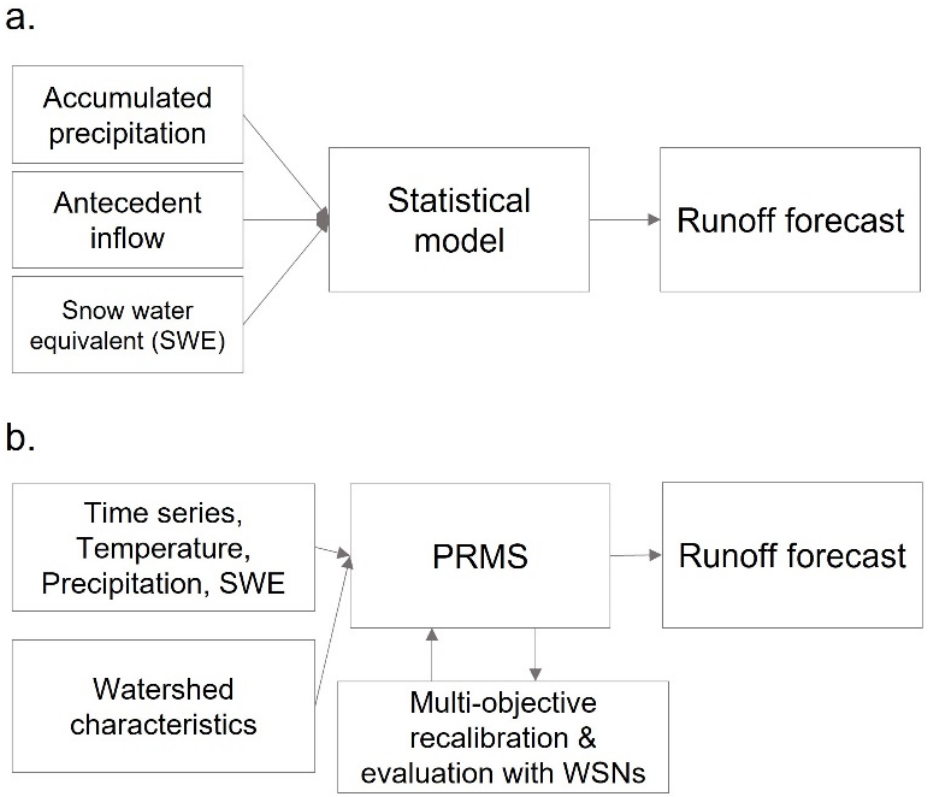
Figure 3. Flowchart of the two runoff forecasting methods: ( a ) the statistical forecast and ( b ) the enhanced forecast using PRMS and wireless sensor data.